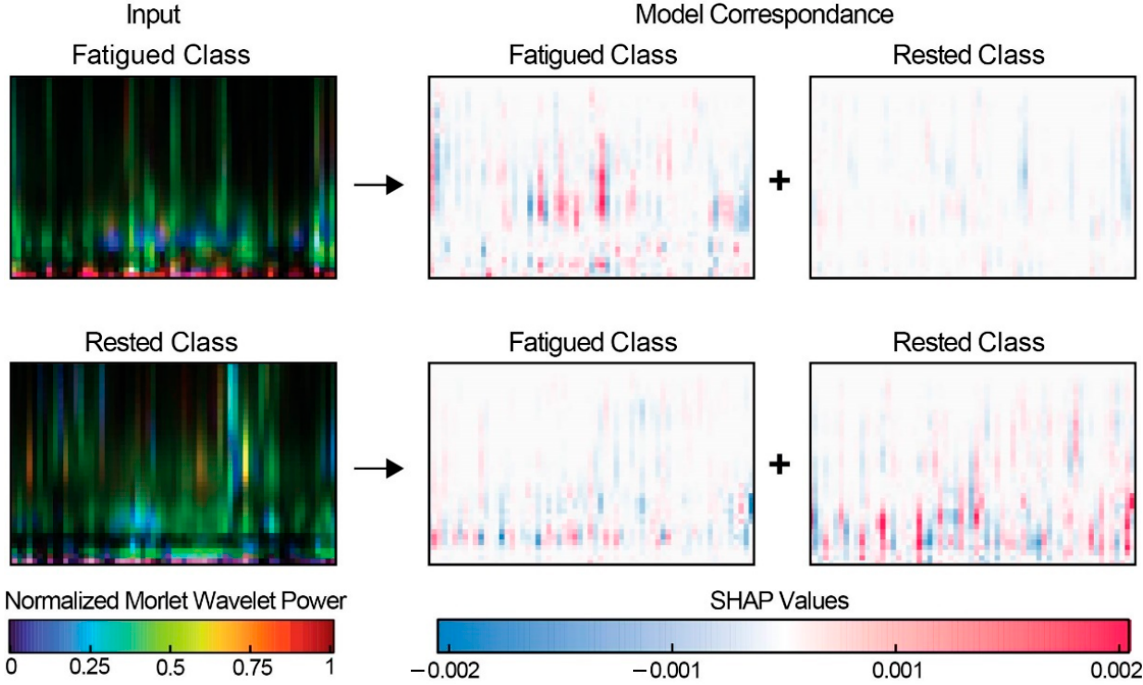
Figure 4. A paradigm of SHAP values representation. The inputs denote the TFR matrices, while the model correspondence reflects the effects of the colored regions in each specific class output. The upper row corresponds to the Fatigued class, while the lower row to the Rested class.